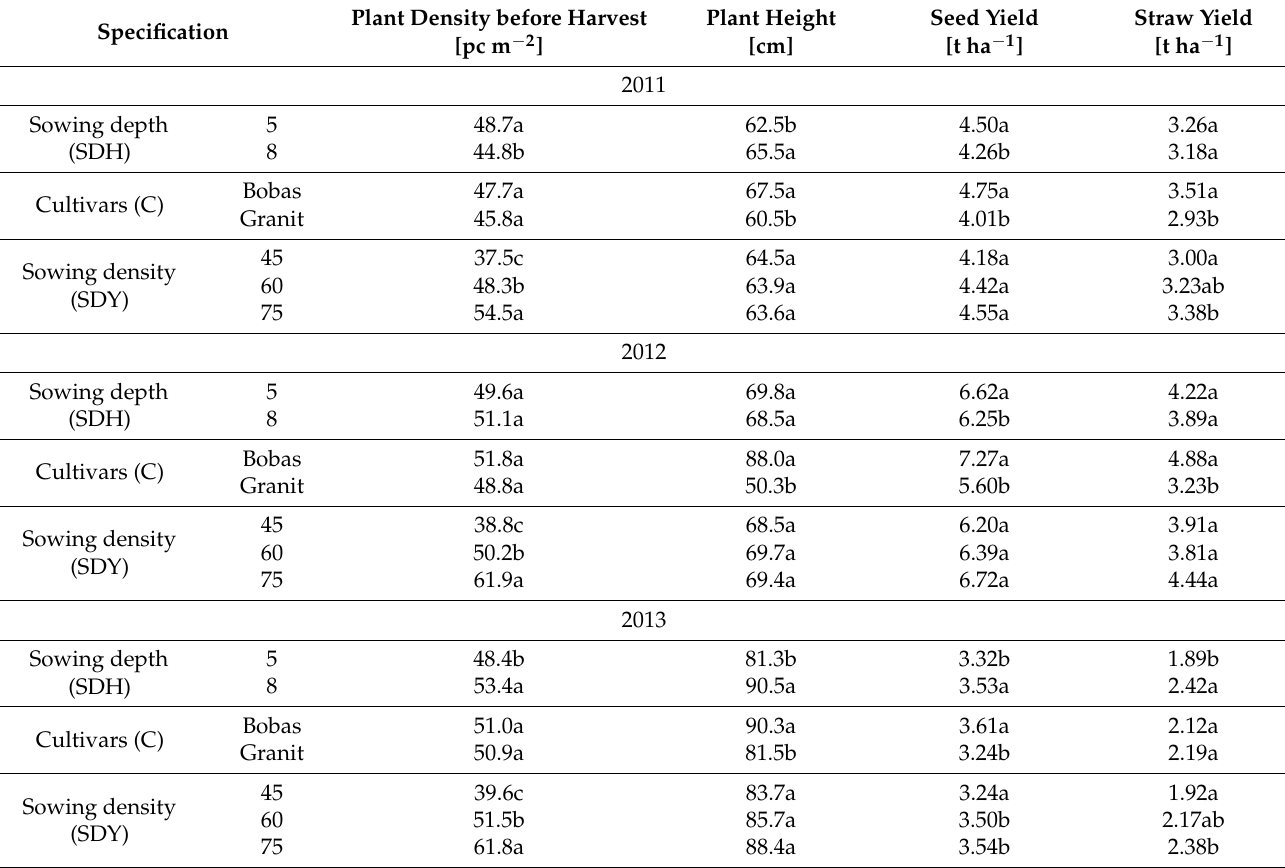
Table 7. Table Effect of examined factors on plant density, height and seed and straw yield.